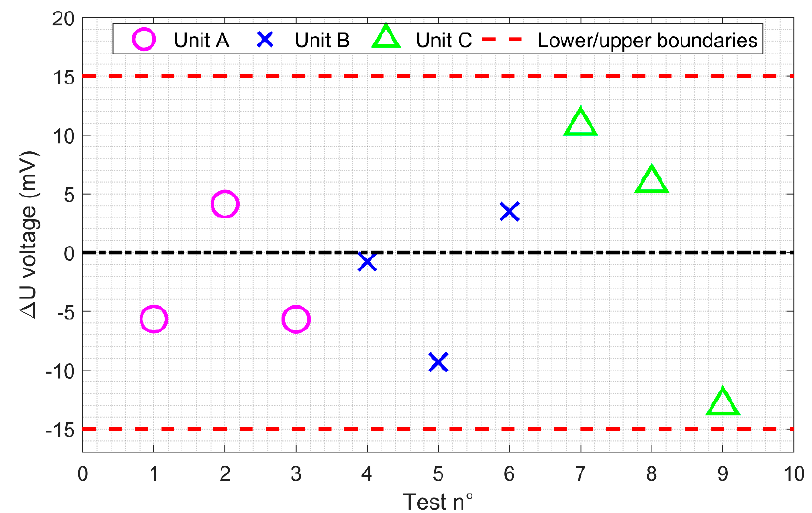
Figure 11. Results of the RVDT adjustments of three servo-actuators each tested three times.